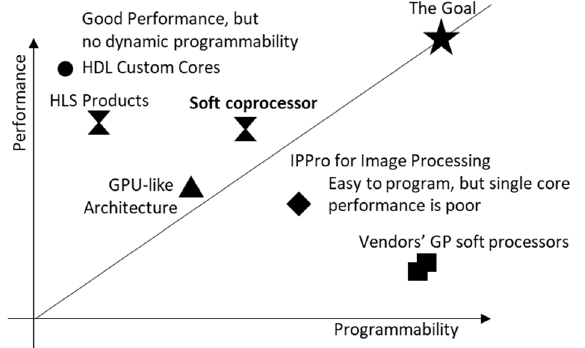
Figure 1. Qualitative representation of programmability vs. performance.